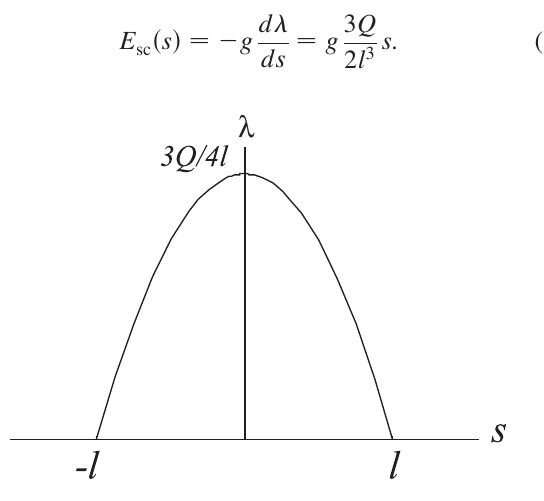
FIG. 7. Parabolic line charge density with ion beam length 2 l .